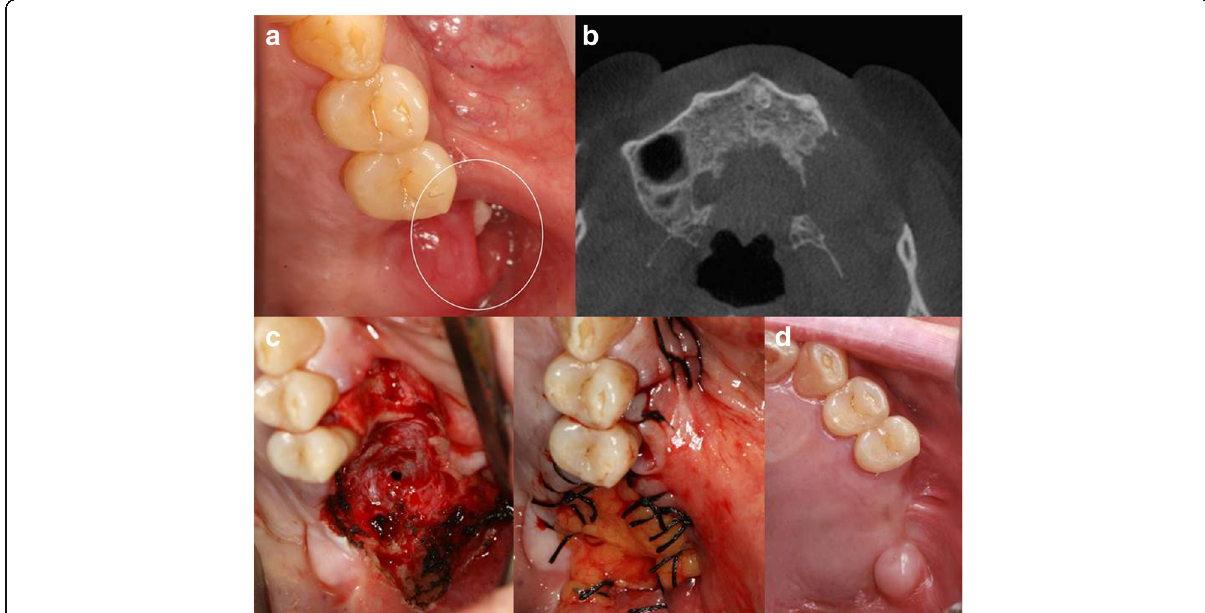
Fig. 3 Case 3. a Preoperative oral examination showed a fistula on the gingiva due to recurrent ameloblastoma lesion (circle). b Preoperative CT showing destruction of alveolar bone on left maxillary posterior area. c During the surgery, a large defect was observed in the left maxillary posterior area due to the ameloblastoma. The pedicled buccal fat pad was used for coverage of the defect. The pedicled flap was exposed. d After 6 months, the site was well epithelized by soft